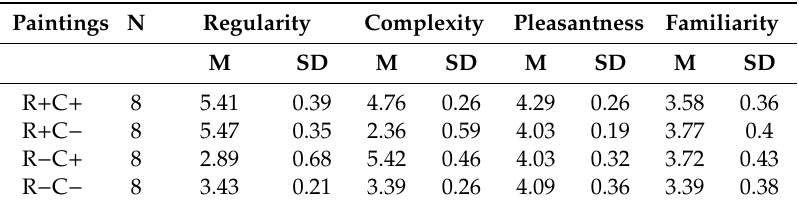
Sets were specified as combinations of either low regularity (R − ) or high regularity (R + ) with both low complexity (C − ) and high complexity (C + ).